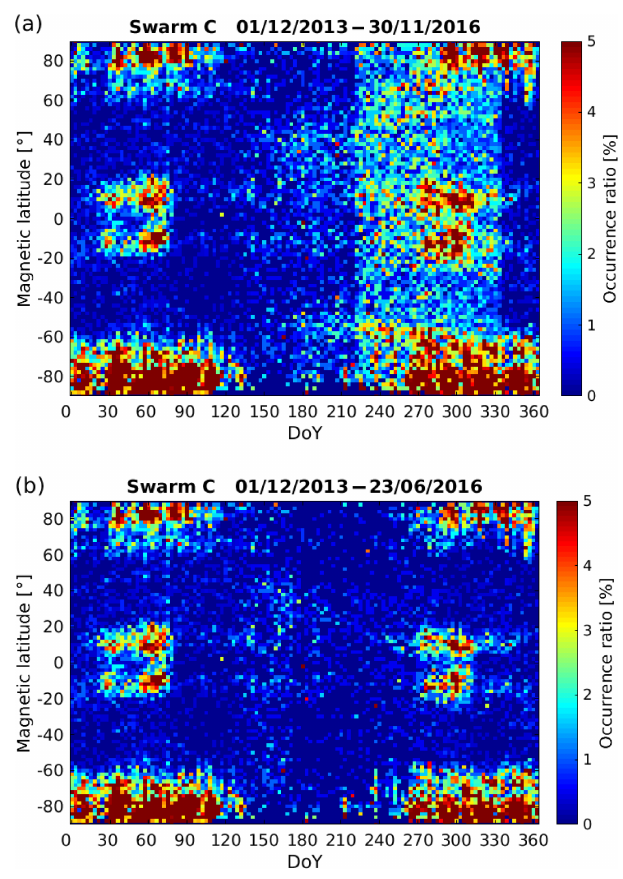
Figure 6. The MLAT vs. DoY distribution of the GPS signal loss events observed by Swarm C during (a) 3-year period from 1 De- cember 2013 to 30 November 2016 and (b) from 1 December 2013 to 23 June 2016 before the PLL bandwidth of Swarm C increased to be larger than